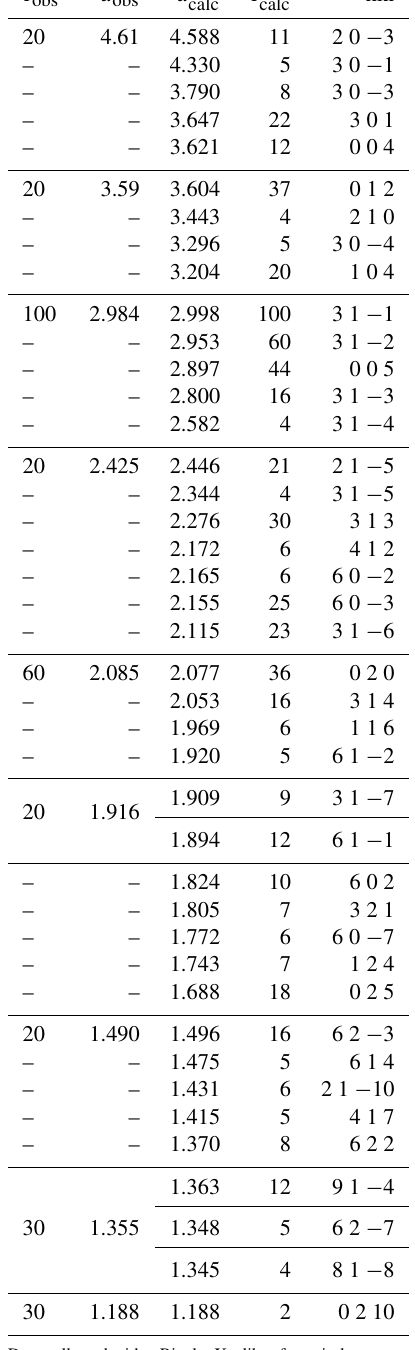
Rigaku detector. Intensities were estimated visually. Calculated intensities were obtained from the structural data with LAZY PULVERIX (Yvon et al., 1977). Calculated d values were refined with LCLSQ (Burnham, 1962); the refined unit cell parameters are a = 13 . 01 ( 13 ) , b = 4 . 15 ( 2 ) , c = 15 . 36 ( 14 ) Å, β = 109 . 4 ( 6 ) ◦ (space group P 2 1 /m) . ∗ Only lines with a calculated intensity higher than 4rel.% are